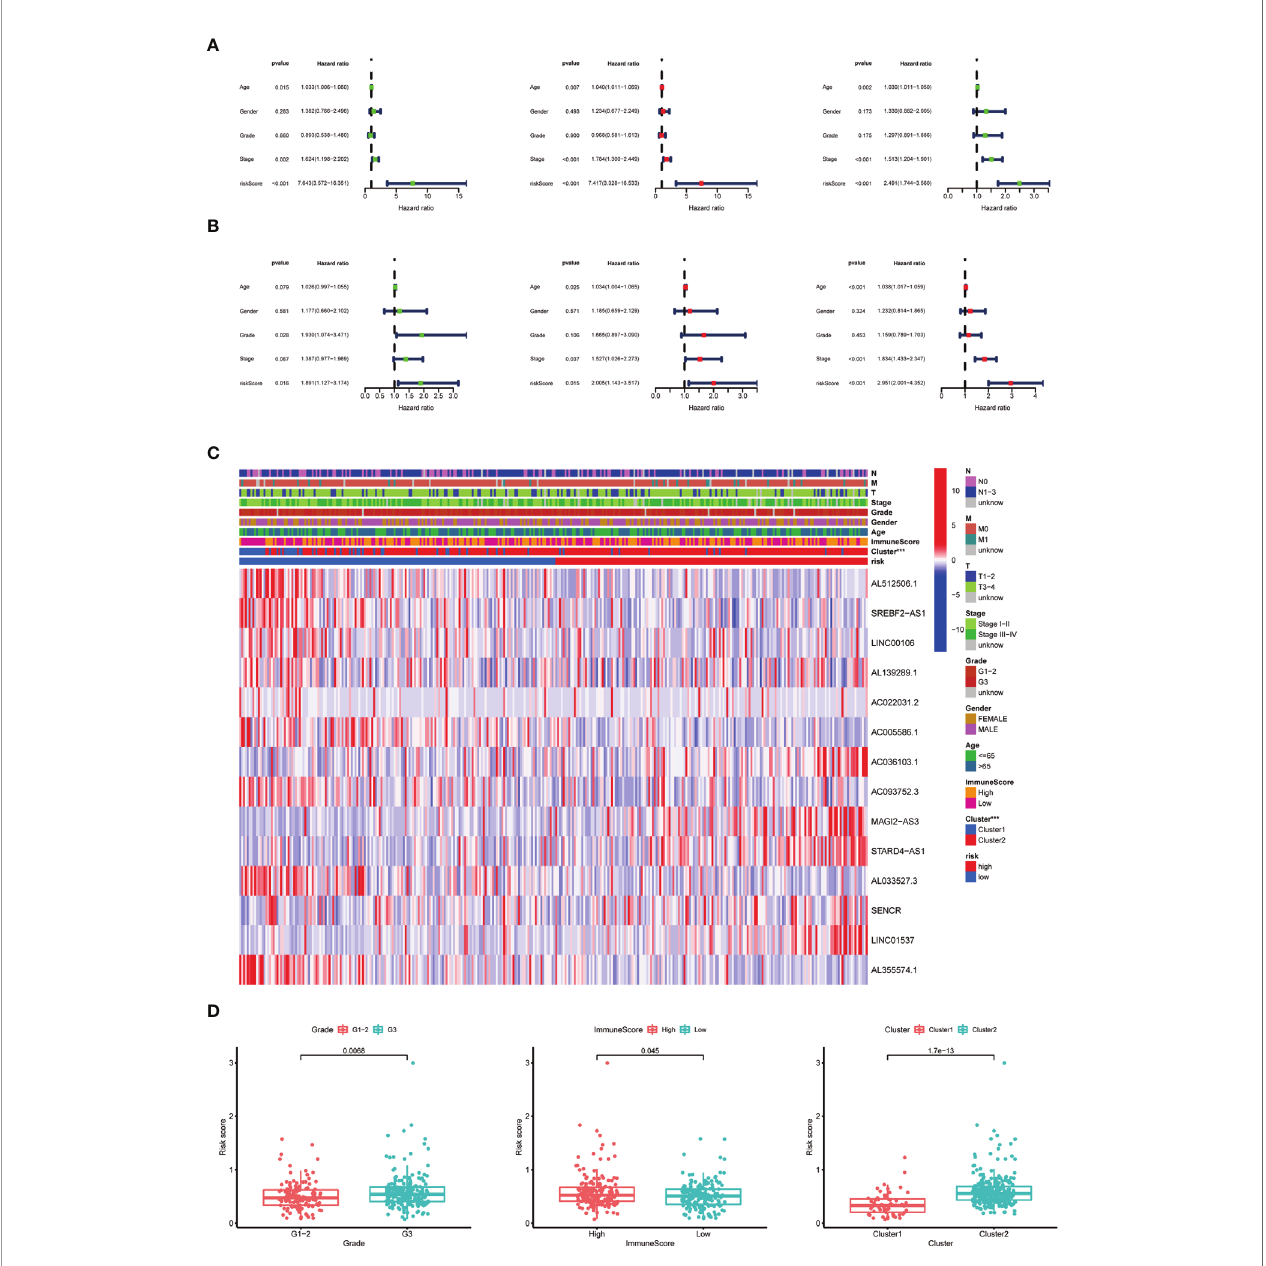
FIGURE 7 | Relationship between the risk score and clinicopathological characteristics. (A) Univariate Cox regression analysis of the association between clinicopathological factors (including risk score) and OS of patients in the training group, the test group, and the combined group. (B) Multivariate Cox regression analysis of the association between clinicopathological factors (including risk score) and OS of patients in the training group, the test group, and the combined group. (C) The heat map showed the expression of 14 m 6 A-related prognostic lncRNAs, the distribution of clinicopathological characteristics, the immune scores of TME, and the clustering of patients in the high-risk and low-risk groups. *** p < 0.001. (D) The risk score was signi fi cantly higher in patients with higher-grade tumors ( p < 0.01), higher immune scores of TME ( p < 0.05), and cluster II ( p <